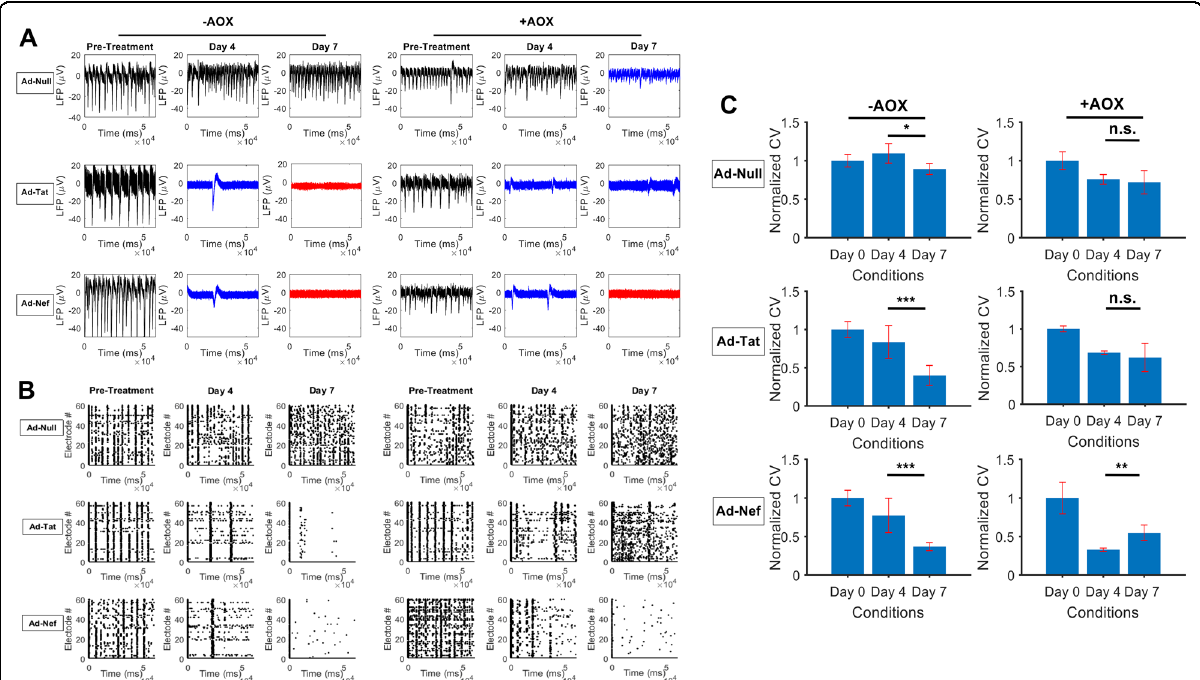
Fig. 5 Neuronal Electrophysiology. A Local fi eld potentials (LFPs) from MEA recordings indicate the expression of Tat and Nef signi fi cantly suppressed neuronal activity, where black, blue, and red color indicate normal, suppressed, and silenced activities, respectively. AOX treatment of Tat expressing neurons was capable of inhibiting further attenuation in network fi ring frequencies and partially stabilizing amplitudes, while treatment in Nef expressing neurons only partially preserved fi ring amplitudes under acute conditions. B Raster plots demonstrated the highly synchronous and regular fi ring activity at baseline was fully mitigated by the expression of Tat or Nef. AOX treatment resulted in a partial restoration of synchronous activity in the Tat expressing group, but not Nef. C Analyses of correlation-based conduction velocities revealed the application of AOX prevented further attenuation in temporal fi ring dynamics in Tat expressing neurons, and improved activity in the Nef expressing group. * p < 0.05; ** p < 0.01; *** p <